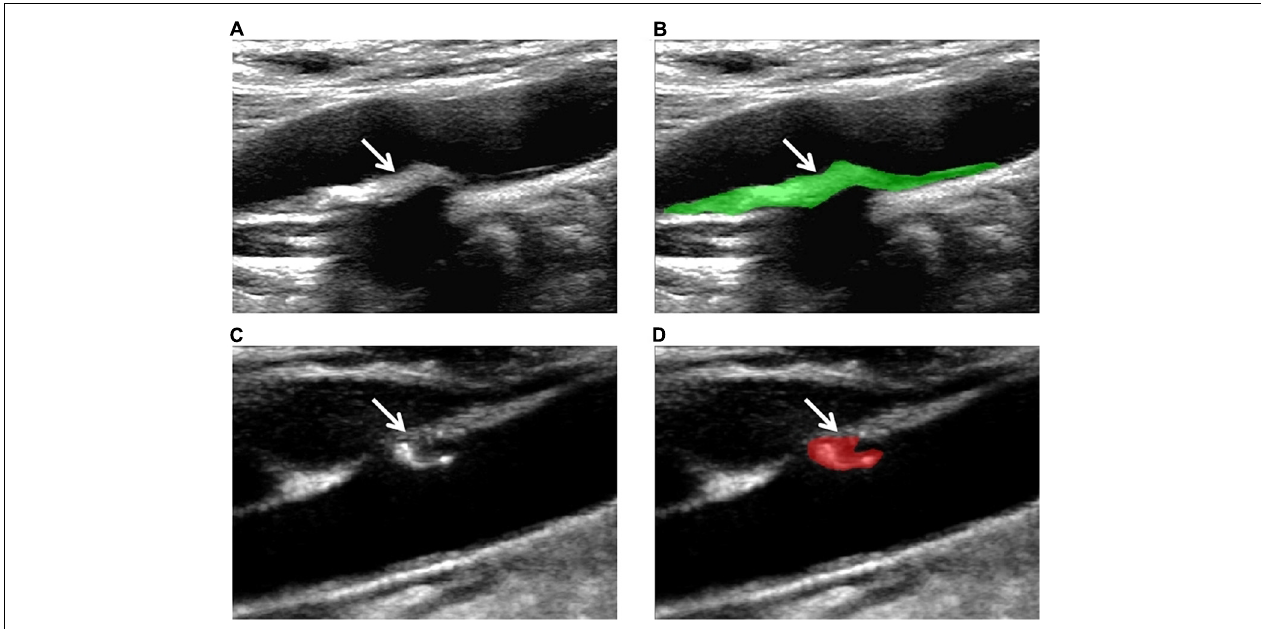
FIGURE 2 | Examples of the manual segmentation in stable and vulnerable plaques. (A) Original ultrasound image of stable plaque (arrow). (B) The segmented area was within the green contour on the largest area on stable plaque (arrow). (C) Original ultrasound image of vulnerable plaque (arrow). (D) The segmented area was within the red contour of the largest area on the vulnerable plaque